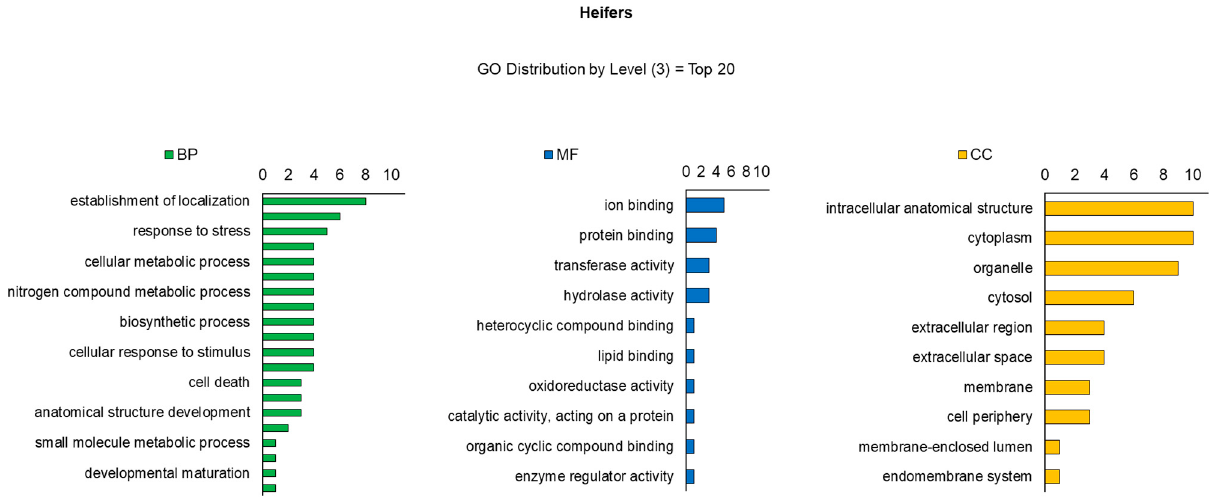
Figure 4. Classification of proteins identified in tissue samples ( Longissimus thoracis ) from immuno-castrated F1 Montana-Nellore young steers feedlot finished. The OMICSBOX software was used to classify the proteins according to biological process (BP), molecular function (MF), and cellular component (CC).